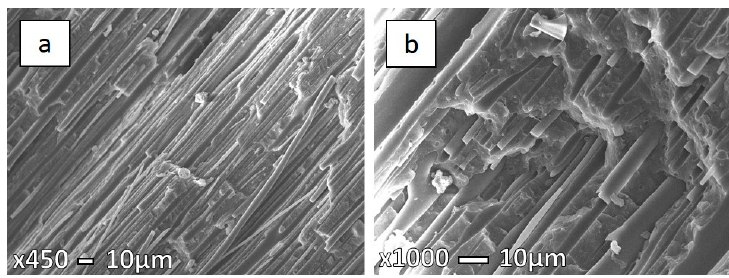
Figure 7. SEM micrographs of freeze-fracture surfaces in the parallel direction under liquid nitrogen